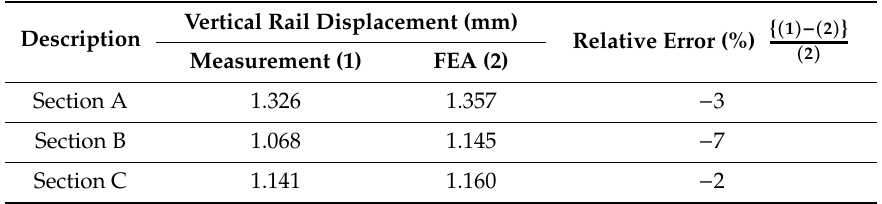
Table 6. Comparison of the finite element analysis (FEA) and field measurements results on the vertical rail